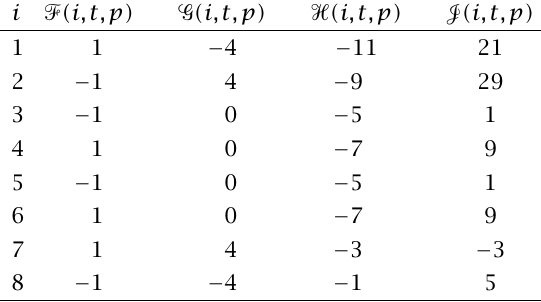
(cid:10) φ( − 1 ),φ(t),φ( 1 − t)